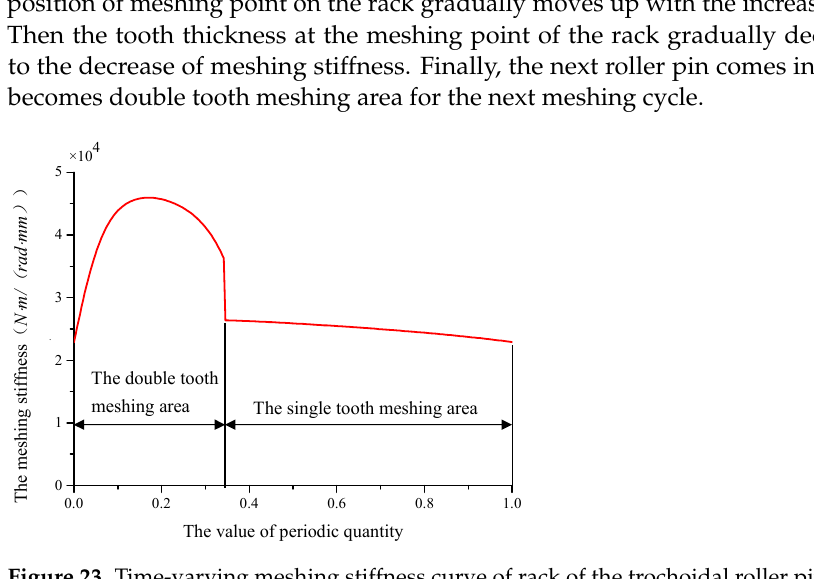
Table 4. Parameters used in meshing stiffness calculation.